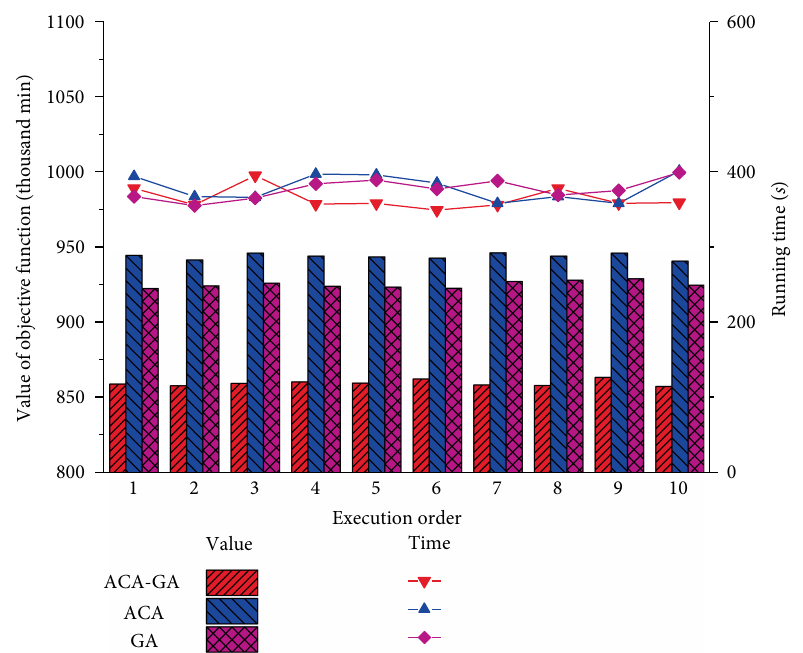
Figure 5: Comparisons of different